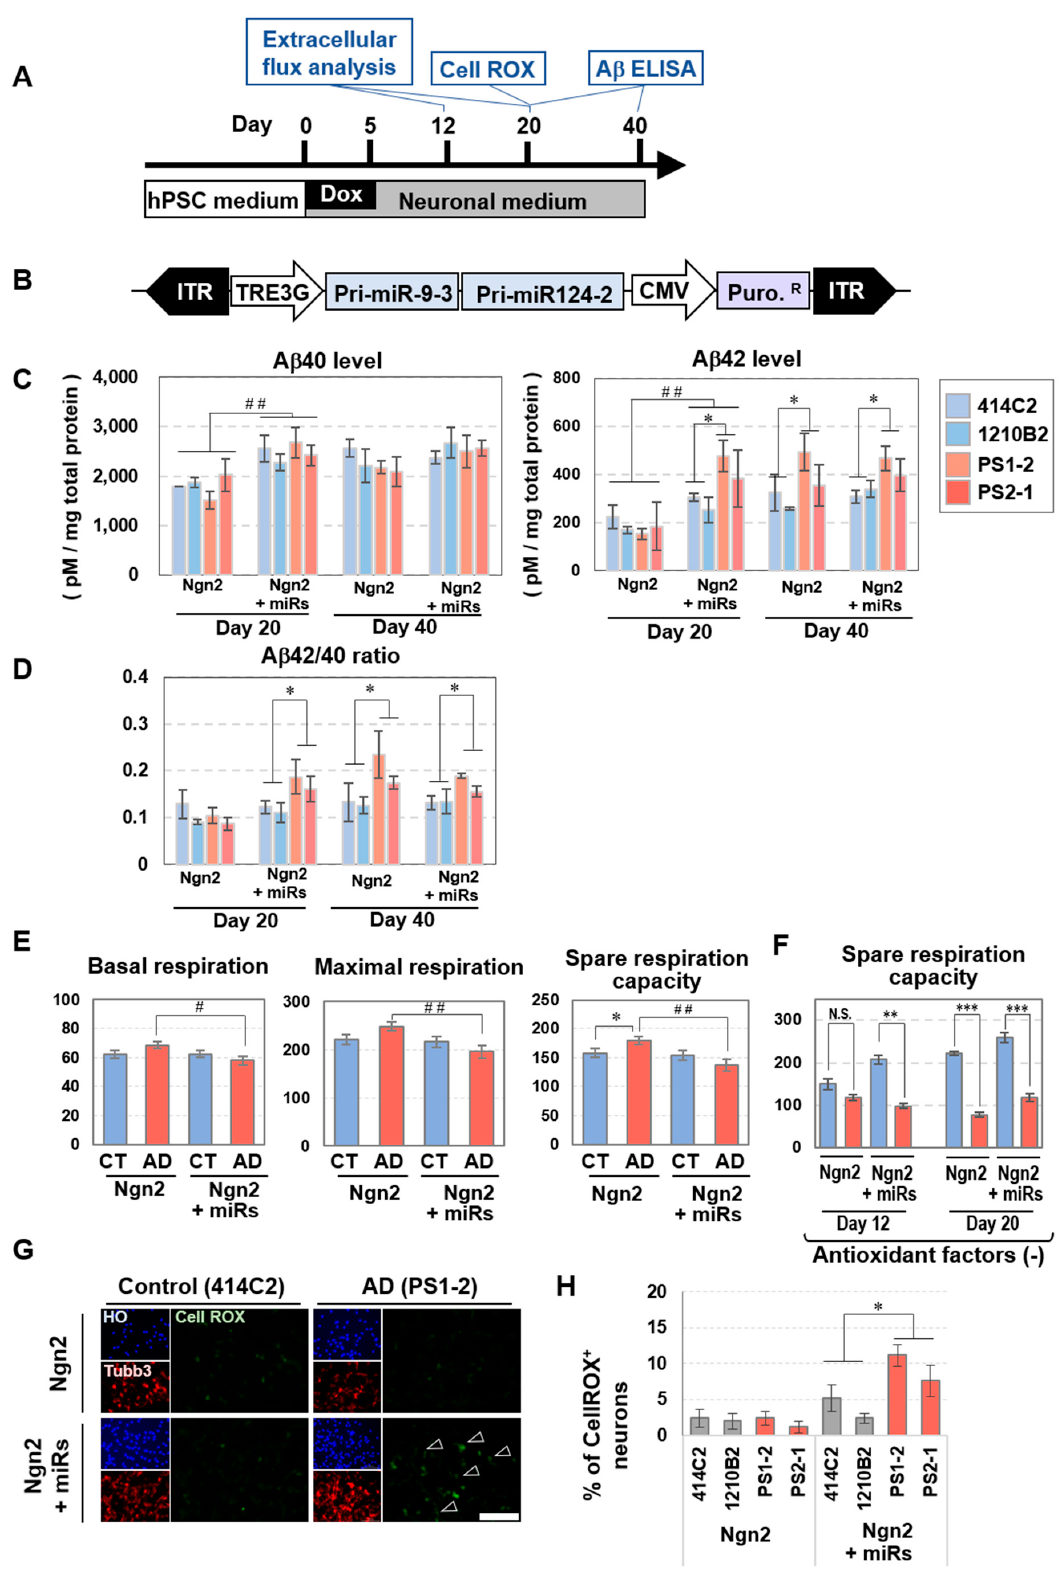
Figure 6. Early phenotype expression of the PS1, PS2 mutant iPS cell-derived neurons by the introduction of miRs. ( A ) Overview of the neuronal culture protocol and phenotype assay. ( B ) Design of the lentiviral vector for Bcl-xL-free miR-9-124-mediated neuronal conversion. The sequences